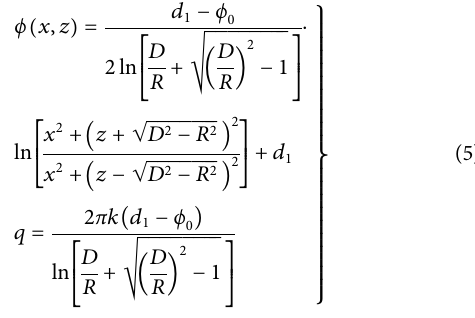
Frontiers in Earth